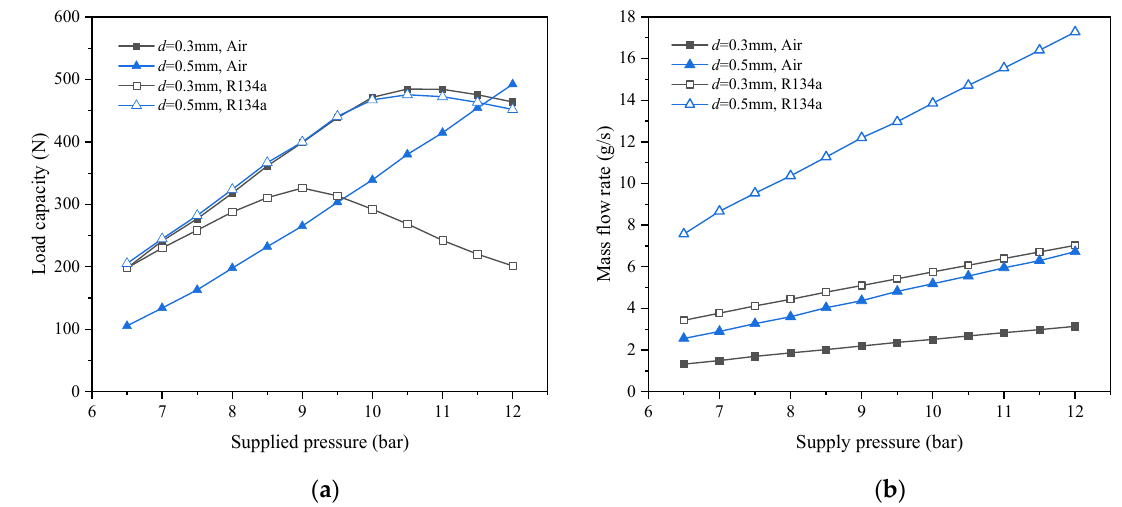
Figure 9. Effect of supply pressure under different orifice diameters ( ε = 0.5, h 0 = 25 μ m) ( a ) on load capacity ( b ) on mass flow rate.